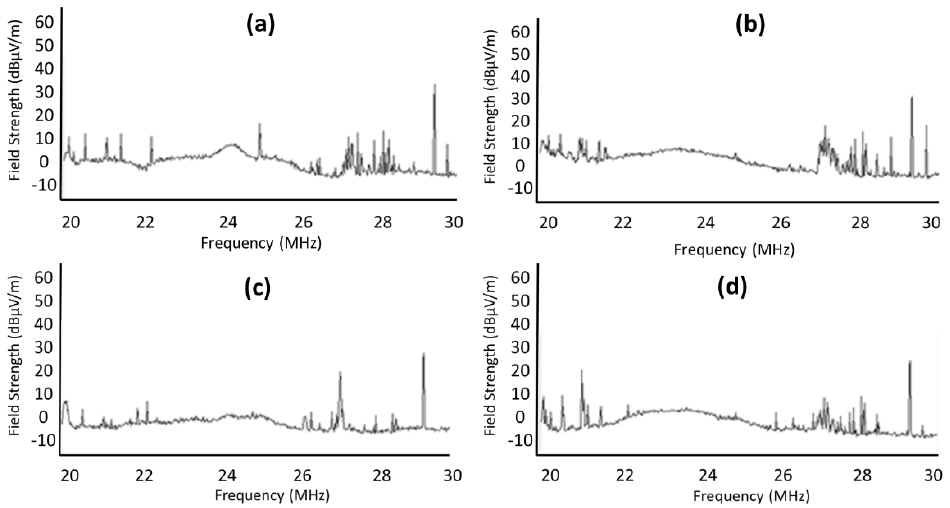
Figure 17. ( a ) 2–30 MHz R&S high angle, ( b ) 2–30 MHz array East–West, ( c ) 2–30 MHz R&S high Figure 17. ( a ) 2-30 MHz R&S high angle, ( b ) 2-30 MHz array East-West, ( c ) 2-30 MHz R&S high angle, and ( d ) 2-30 MHz array North-South. angle, and ( d ) 2–30 MHz array North–South.